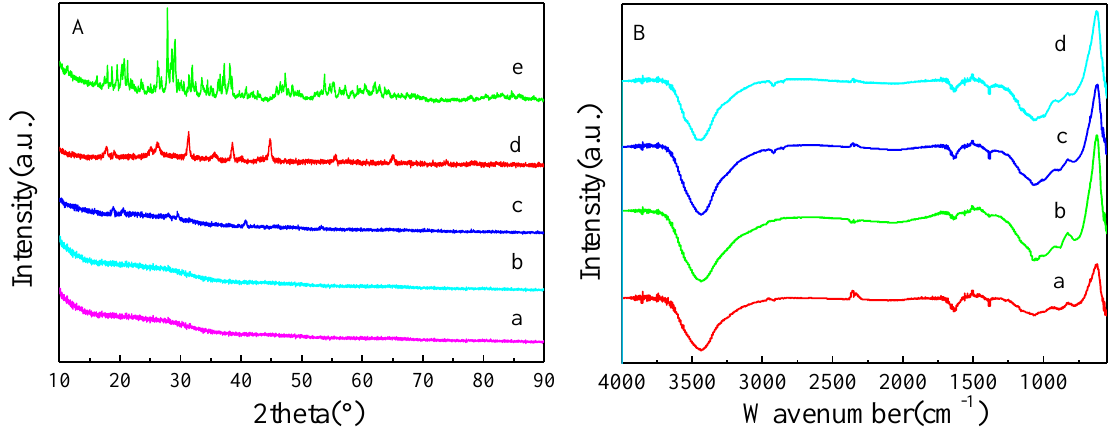
Figure 3. ( A ) XRD patterns of (a) SF-HPC, (b) 1%HPW/SF-HPC, (c) 5%HPW/SF-HPC, (d) 10%HPW/SF-HPC, and (e) HPW. ( B ) FT-IR spectra of (a) SF-HPC, (b) 1%HPW/SF-HPC, (c) 5%HPW/SF-HPC, and (d) 10%HPW/SF-HPC.